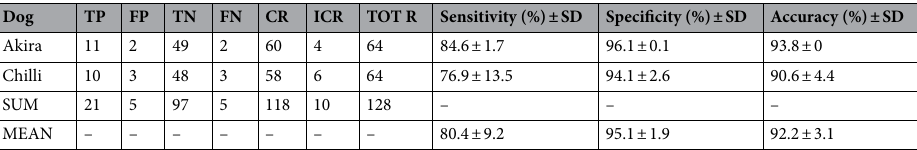
Table 1. Mean results presented as sensitivity, specificity and accuracy in percent, including ± standard deviation (SD), calculated from 16 randomized and double-blind experimental searches on a scent platform that was carried out between the 17th and 19th of December 2018 at the University of Southeast Norway including both invasive and native wood borers. A dog`s response to a scent sample could be either; TP true positive response, FP false positive response, TN true negative response and FN false negative response. CR total number of correct responses, ICR total number of incorrect responses, and TOT R total number of responses.